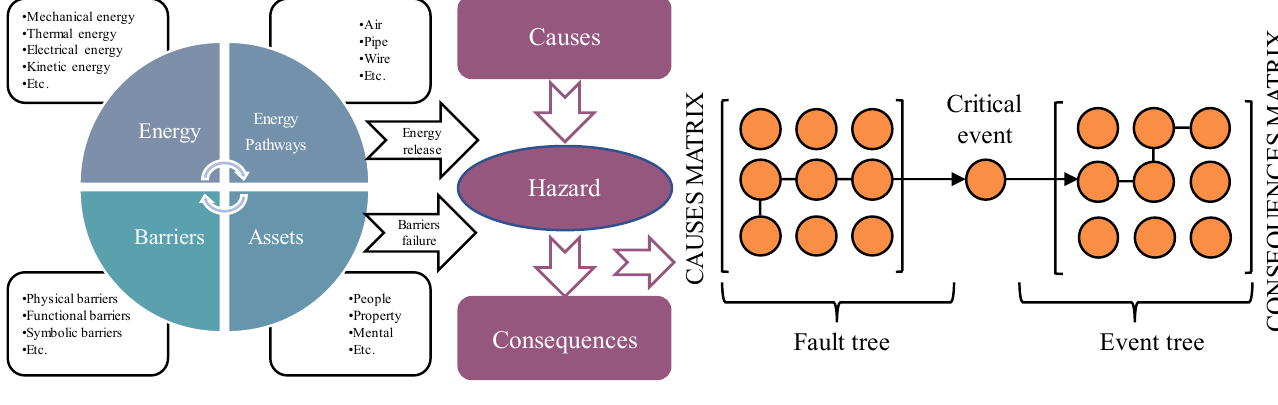
Figure 1. Energy and barrier theory, preliminary hazard analysis, and bow-tie diagram (EPB) model.